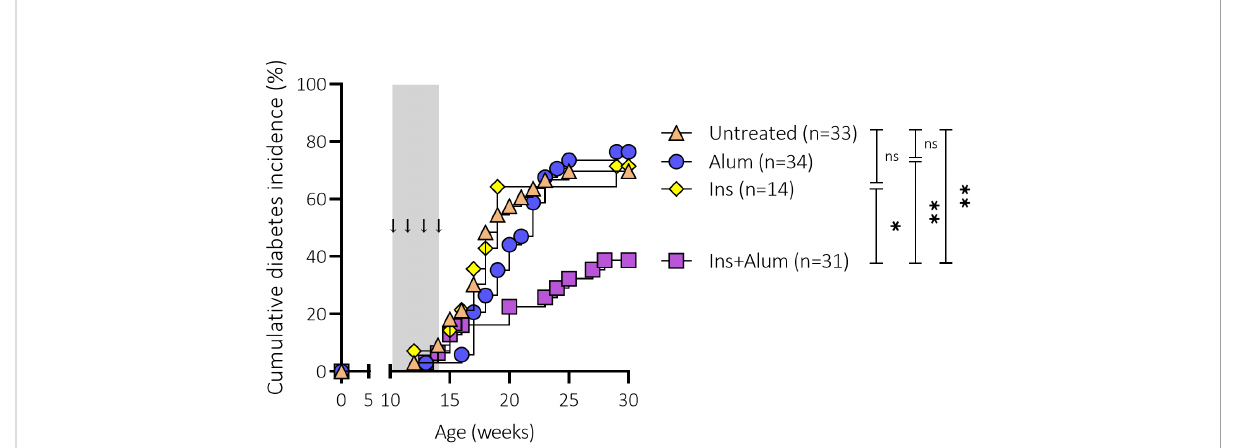
FIGURE 1 Effect of four weekly subcutaneous injections with InsB:8-24 peptide (Ins) formulated in alum on diabetes incidence in female NOD mice. Female NOD mice received four weekly subcutaneous injections, starting from 10 weeks of age and continuing until 13 weeks of age, of InsB:8- 24 peptide formulated in alum (Ins+alum), InsB:8-24 peptide dissolved in buffer (Ins), alum alone (alum), or left untreated (Untr). Kaplan-Mayer survival curves depict the cumulative diabetes incidence over time. Mice (n = 14-34 per group) with two consecutive measurements of blood glucose levels >200 mg/dL were considered diabetic. Grey area indicates the timeframe of treatment, arrows indicate time points at which the therapies were administered. ns, not signi fi cant; *P ≤ 0.05; **P ≤ 0.01; NOD, non-obese